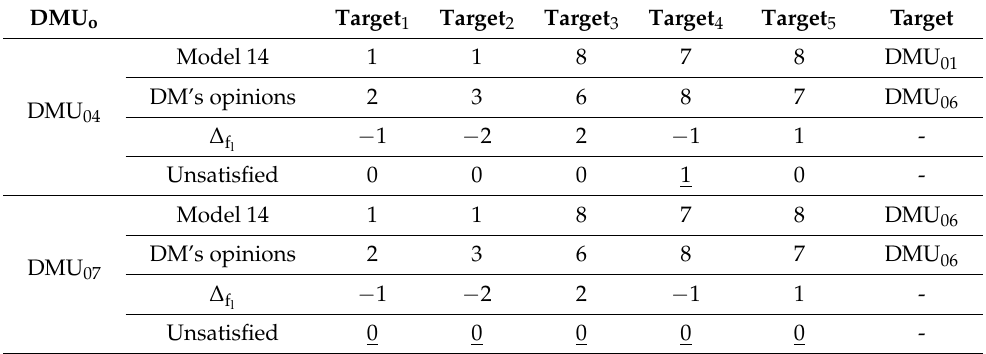
Table A6. The results of solving model 14 (Step 2 of STEM for p = 2) and DM’s opinions about them for two DMUs in the second case